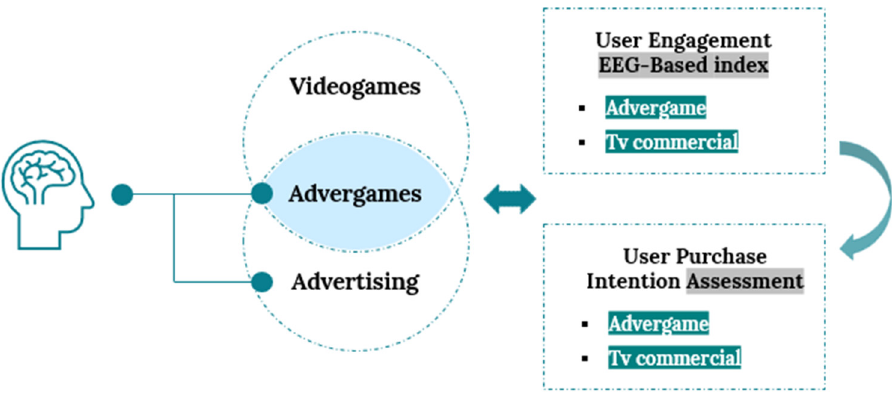
Figure 1. Model of UE influence on UPI.